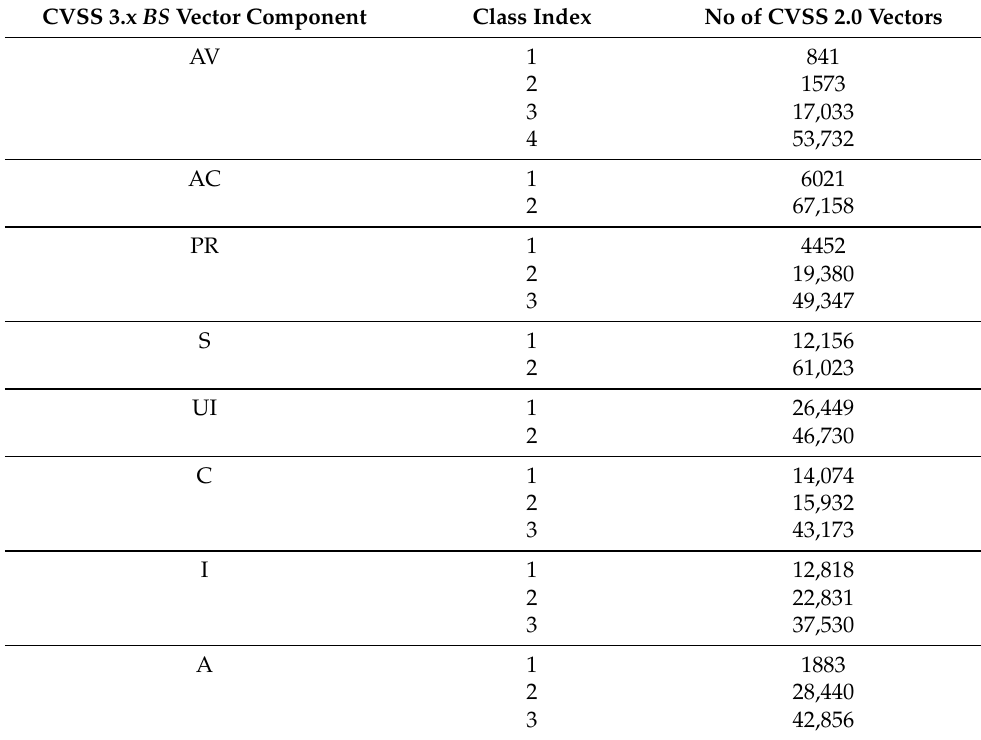
Table 3. The number of CVSS 2.0 vectors that map onto a specific class of the CVSS 3.x vector. CVSS 3.x BS Vector